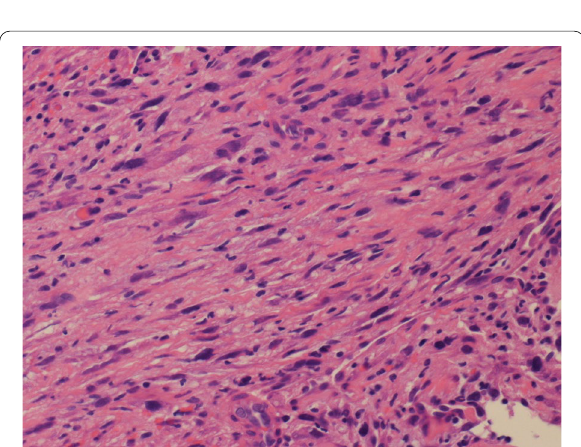
Fig. 4 Esophagojejunostomy using overlap technique by thoracoscopic